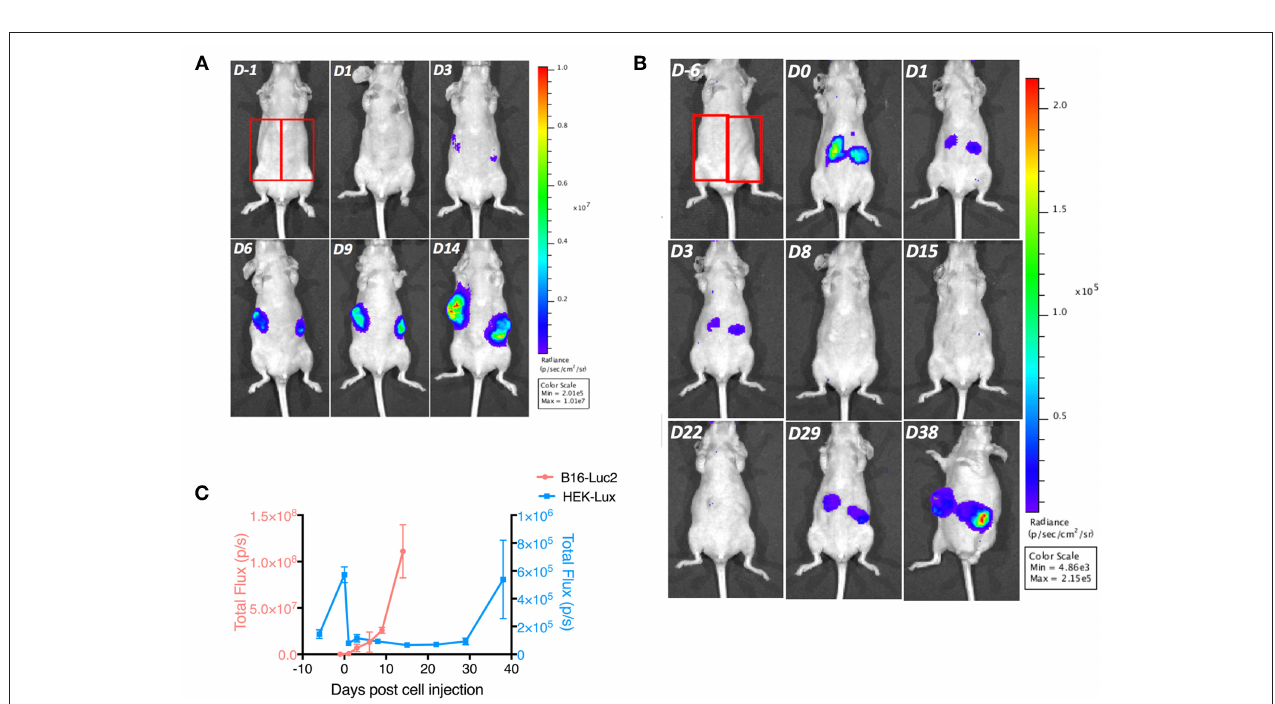
FIGURE 3 | Tumor bioluminescence signal evolution imaging over time. (A) B16-Luc2 cells (8 × 10 4 , 0.1mL) were subcutaneously administered in nude mice. Mice were imaged 1 day prior and 1, 3, 6, 9, and 14 days post-administration of B16-Luc2 cells, n = 5. (B) HEK-Lux cells (5 × 10 6 , 0.1mL) were subcutaneously adminstered in nude mice. Mice were imaged 6 days prior and 0, 1, 3, 8, 15, 22, 29, and 38 days post-administration of HEK-Lux cells, n = 6. (C) Bioluminescence signal quantitation of B16-Luc2- and HEK-Lux-induced tumors. Red rectangles in 2A and 2B show the ROI used for quantification. Results express the total flux (photons/s) in the ROI of the left tumor of the mice. These results are representative of 4 independent